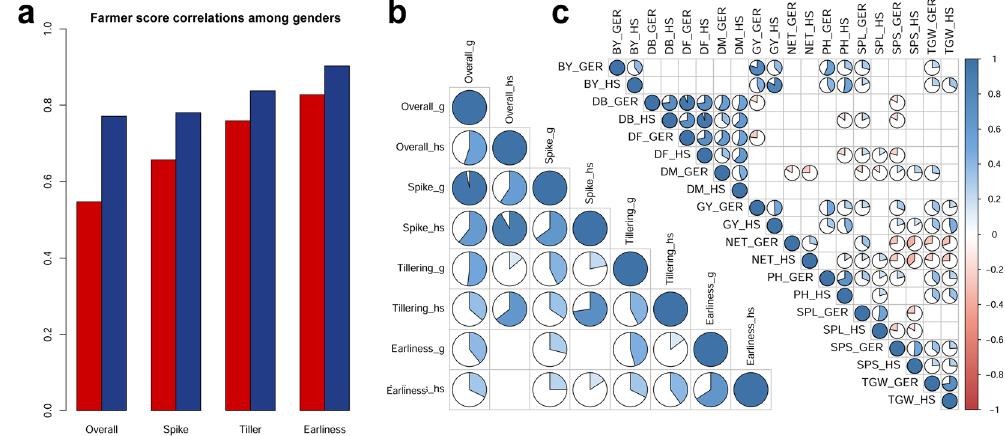
Figure 1. Farmer score and phenotype correlations between genders and between locations. ( a ) Score consistency between genders in the two locations. On the y axis, Spearman correlation coefficients (all significant). Red bars represent correlation values between men and women scores in Hagreselam, blue bars represent those correlations in Geregera. Gender correlations are higher in agronomic traits, earliness and tillering , and lower in quality traits, spike and overall . ( b ) PE scores consistency between the two locations (“h” for Hagreselam and “g” for Geregera). The value of Spearman’s correlations is shown by the width of pie slices colored according to the bar on the far right. The combinations without pie charts correspond to non-significant correlations. ( c ) Correlation plot of metric measures of agronomic traits in the two locations. Correlation values are shown as in panel (b), phenotype codes as in Materials and Methods. NET and BY were the agronomic traits most varied across